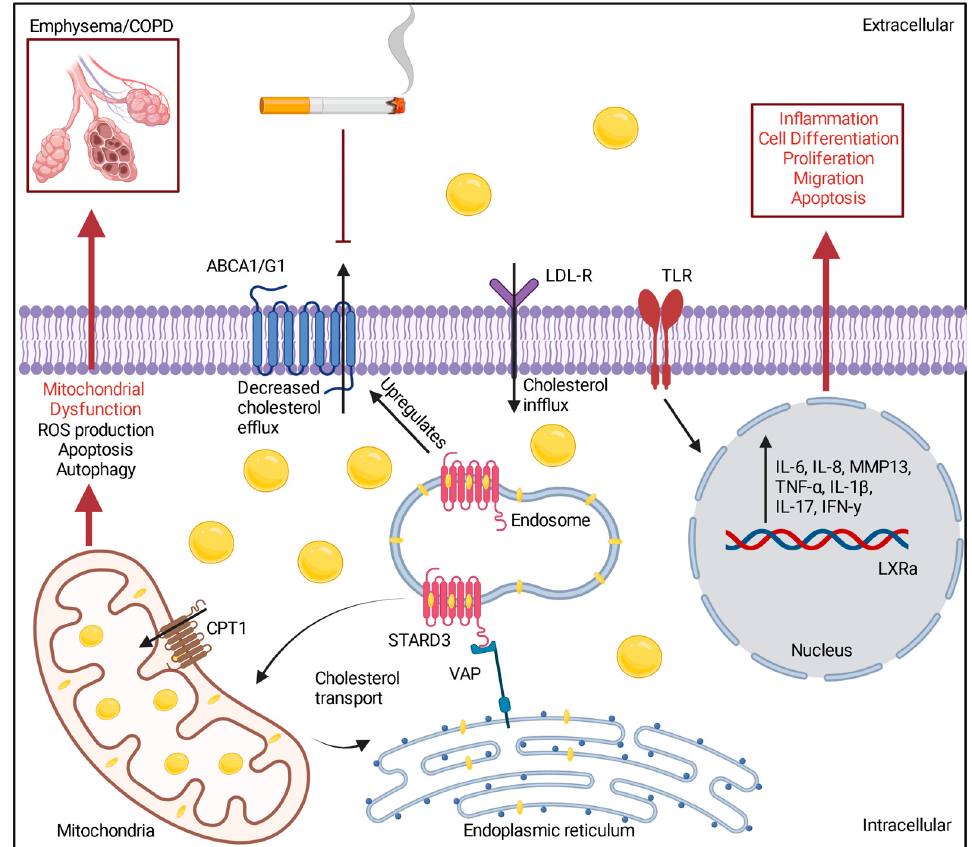
Figure 1. Possible cholesterol signaling that contributes to mitochondrial dysfunction, inflamma- tion, and loss of lung function in COPD. Created with BioRender.com. and loss of lung function in COPD. Created with